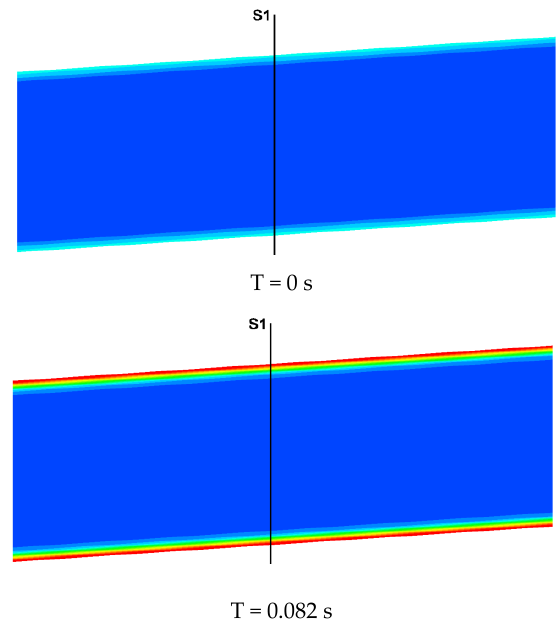
= 0 s and T = 0.082